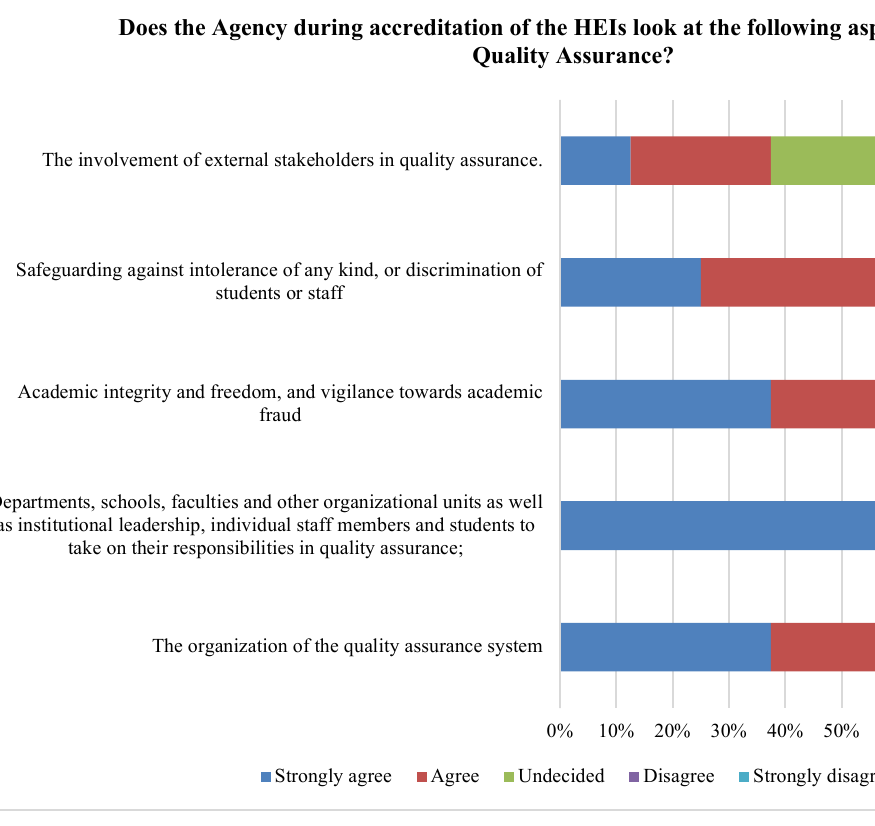
Figure 1: Policy for internal quality assurance in the HEIs in